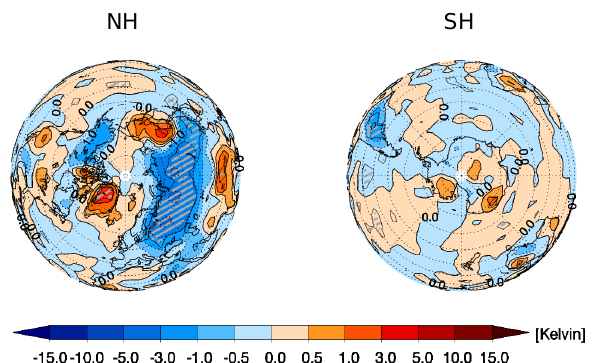
Fig. 9: Left panel : Polar stereographic projection of changes in surface air temperature for the 485 Fig. 9. Left panel: polar stereographic projection of changes in sur- NH for November resulting from the Carrington-like Event. Right panel : Same for the SH. 486 face air temperature for the NH for November resulting from the Hatched areas show 95 % statistical significance. 487 Carrington-like Event. Right panel: same for the SH. Hatched areas show 95% statistical